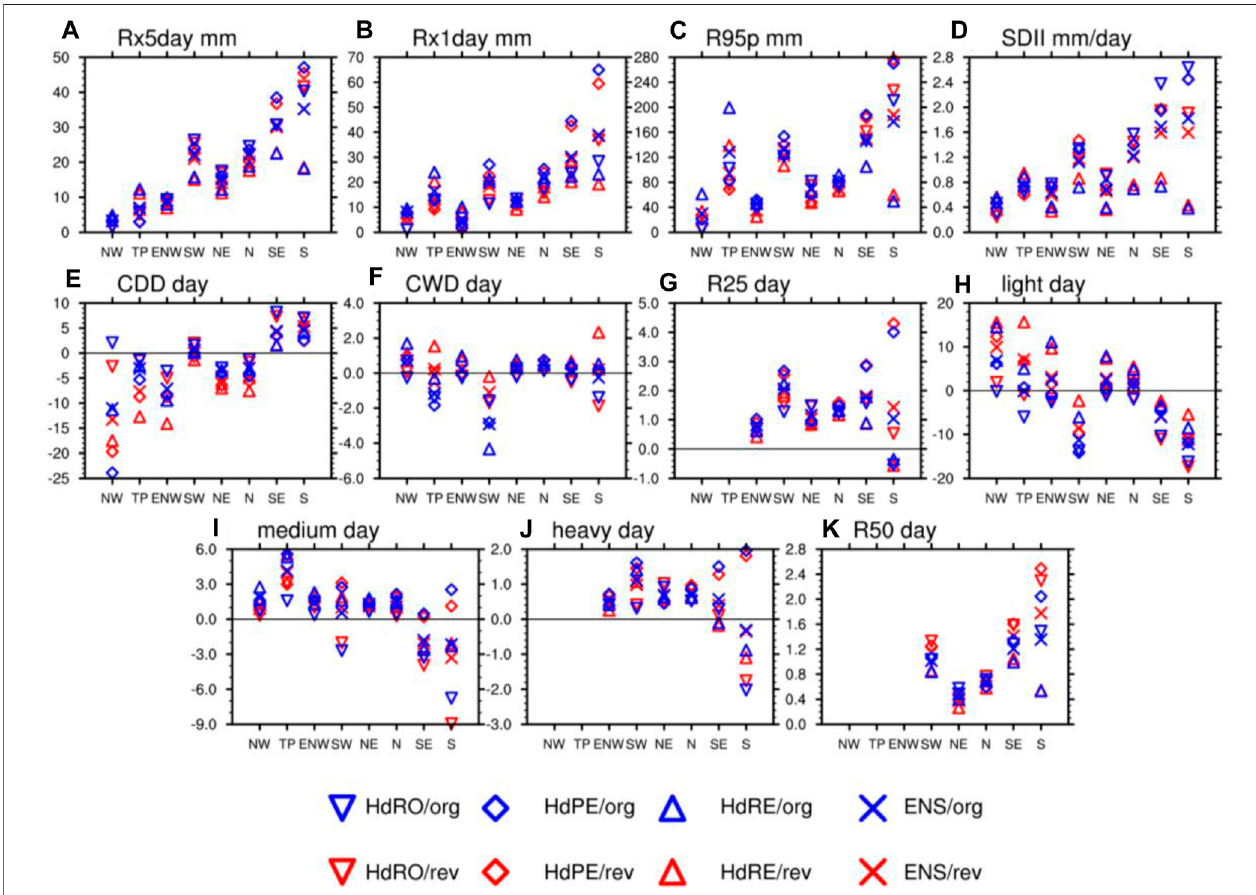
FIGURE 12 | Change ratios of extreme precipitation (A – D) , drought indexes (E,F) and precipitation days (G – K) in the late 21st century (2066 – 2095).